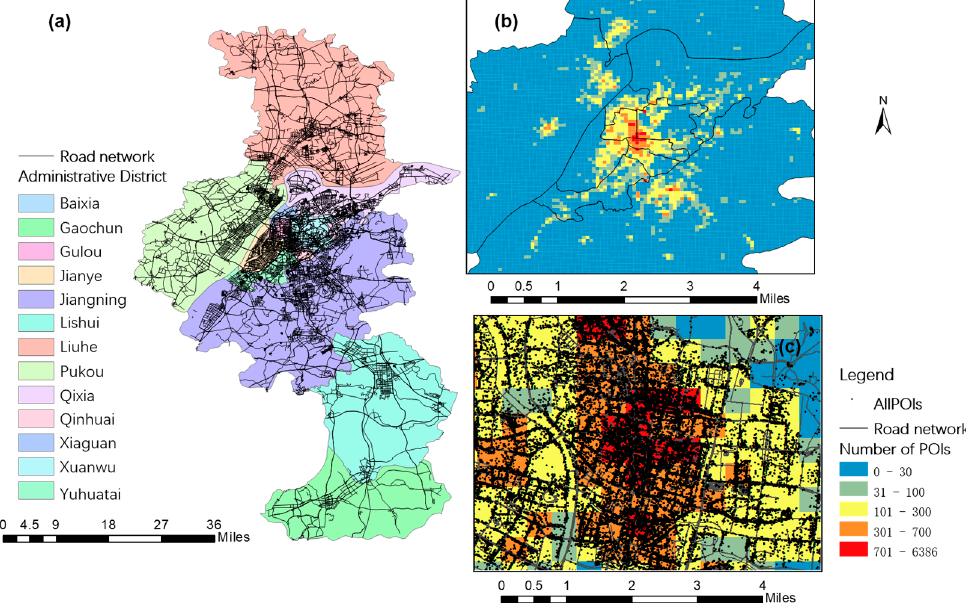
Figure 2. Illustration of the study area (Nanjing, China): ( a ) distribution of the Nanjing road network and 13 districts in China, ( b ) spatial distribution density of all the POIs, and ( c ) detailed map of some POI distributions.